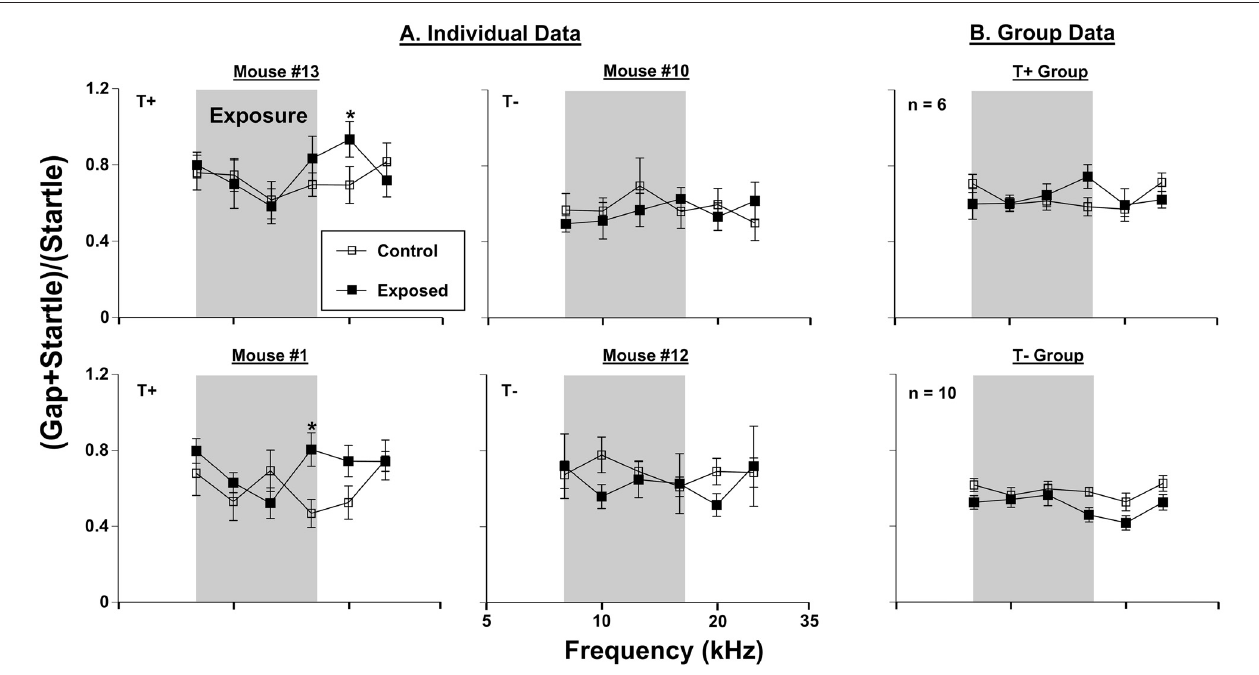
FIGURE 1 | Gap-induced prepulse inhibition of the acoustic startle reflex (GPIAS) assessment for tinnitus. (A) Four individual mice were tested before (control) and 3 months (exposed 3M) after sound exposure. (B) Group GPIAS data for T+ mice ( n = 6) and T − mice ( n = 10), in the same conditions as (A) . The narrow band exposure stimulus is represented by a gray box. Data are represented by ratio means and standard errors. Tinnitus was identified as a significant ( ∗ ) difference between control and exposed conditions. Tinnitus positive and negative mice are labeled as (T+) and (T − ),